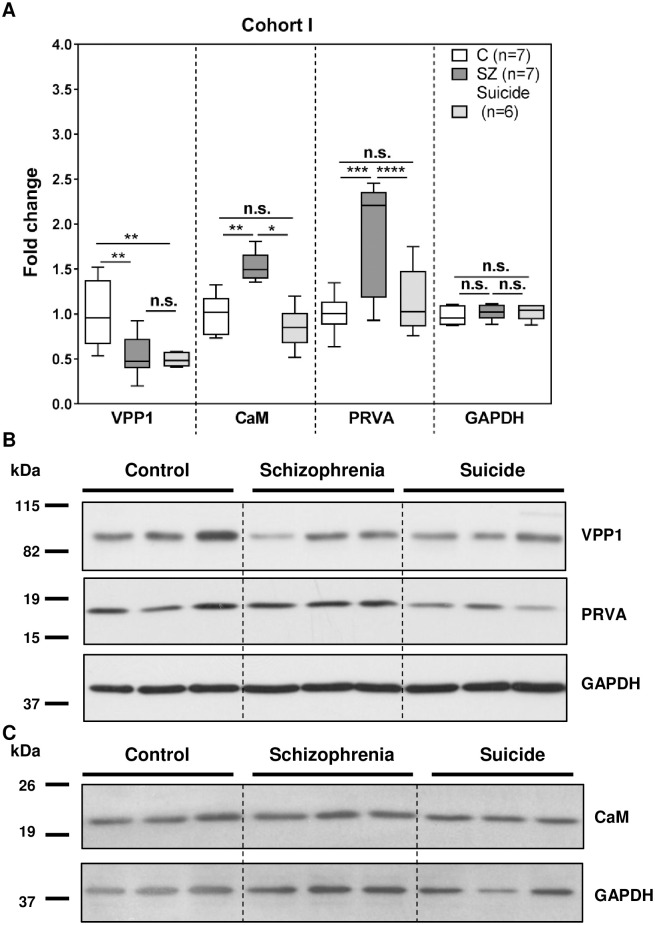
Validation analysis of hit candidate proteins by immunoblot in Cohort I.Protein extracts from samples of the post-mortem cerebellum of non-psychiatric control (C, n = 7), schizophrenia (SZ, n = 7) and non-schizophrenia suicide (n = 6) subjects (Table 1, Cohort I) were analysed by immunoblot for VPP1, PRVA, calmodulin (CaM) and GAPDH and quantified by densitometry. (A) Protein levels for each were normalized to GAPDH values and to the mean of the control samples. Each box plot represents the median, interquartile range and range of each group from at least two independent determinations. Statistical analysis was performed using the Kruskal-Wallis test for differences between groups (VPP1: p = 0.0095; PRVA: p = 0.0011; CaM: p = 0.0270) and the t test for comparison between the indicated groups. (n.s.-not significant, *p<0.05, **p<0.01, ***p<0.001, ****p<0.0001). (B) Representative Western blot images for VPP1, PRVA and GAPDH in 3 non-psychiatric control individuals, 3 schizophrenia subjects and 3 non-schizophrenia suicide controls. (C) Representative Western blot images for CaM and GAPDH in 3 non-psychiatric control individuals, 3 schizophrenia subjects and 3 non-schizophrenia suicide control. See S1 Raw images for complete western blot images.